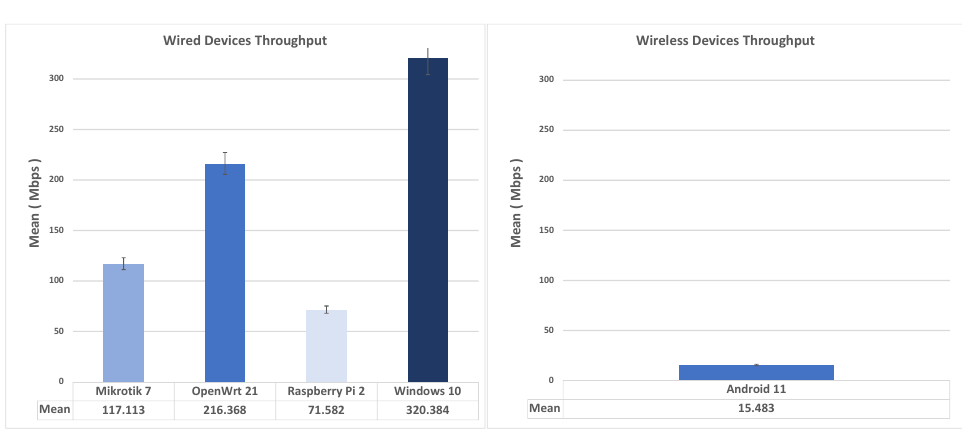
Figure 11. Comparison of the average Throughput in SSTP Road Warriors scenario.